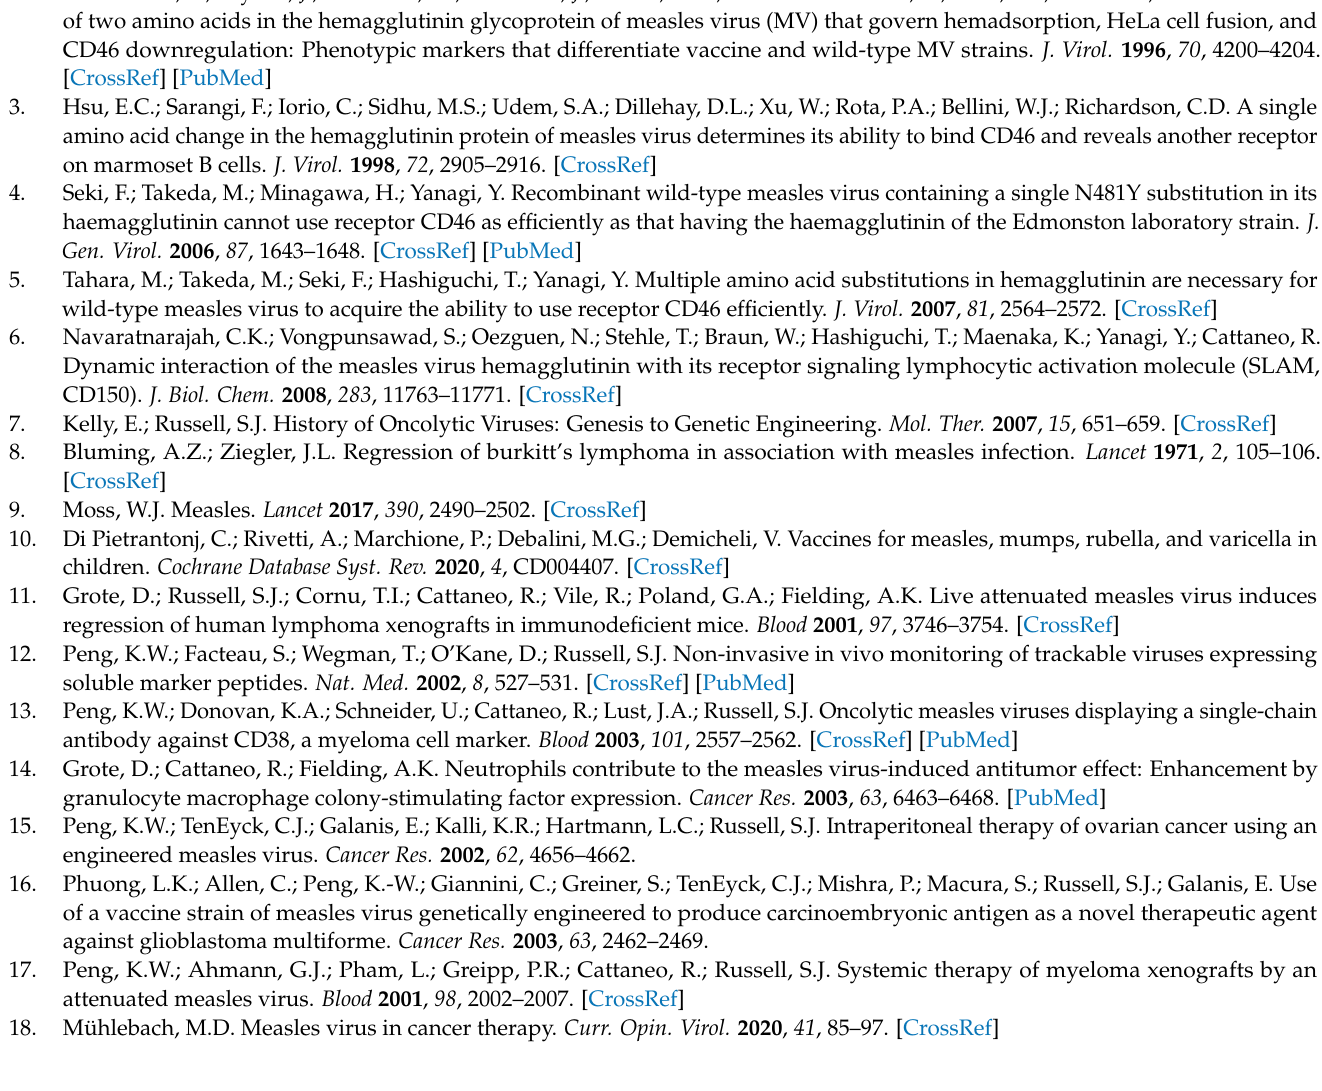
Figure 1c. Graphical abstract, Figures 1a, 2–4 were created with